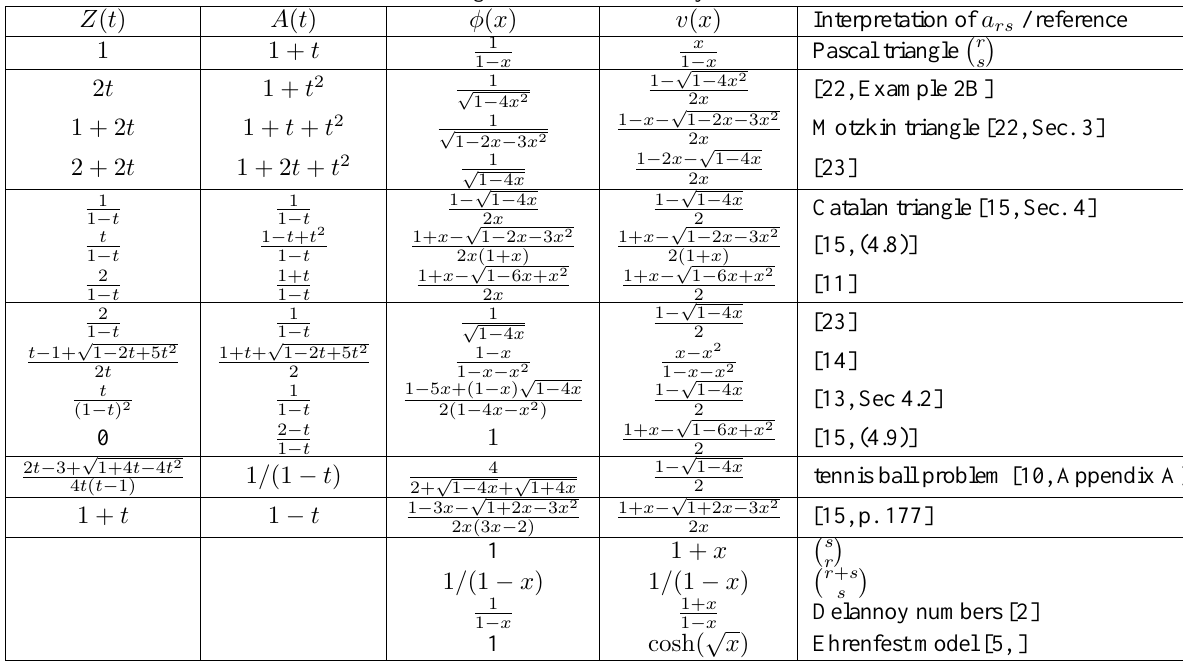
Tab. 1: Some generalized Riordan arrays